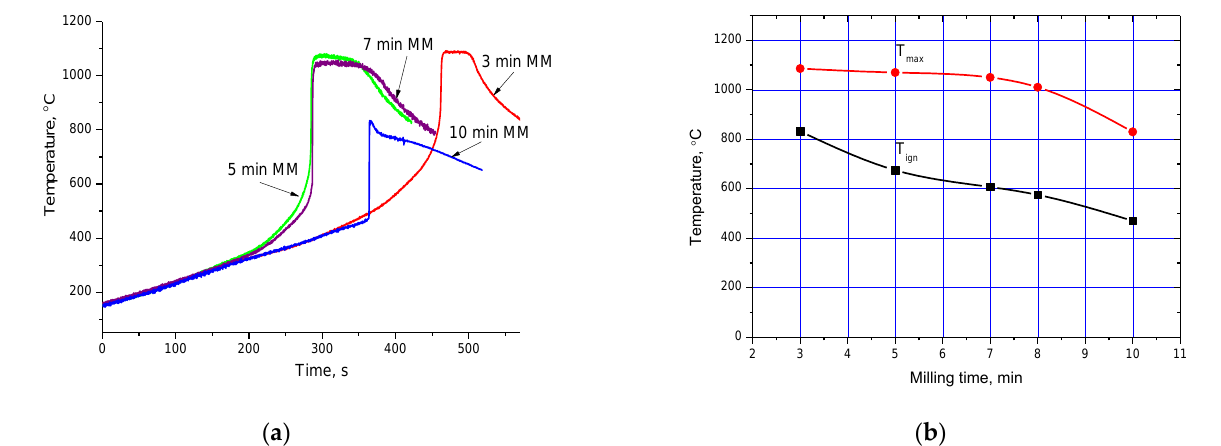
Figure 4. Thermograms of thermal explosion in the Ti – C – 3Cu mixtures high-energy ball milled for different periods of time; the thermograms were recorded upon heating at a rate of 50 °C min −1 ( a ) and dependences of the maximum temperature T max and ignition temperature T ign on the milling time for the Ti – C – 3Cu mixture ( b ) Reprinted from [25], Copyright (2021), with permission from Elsevier.